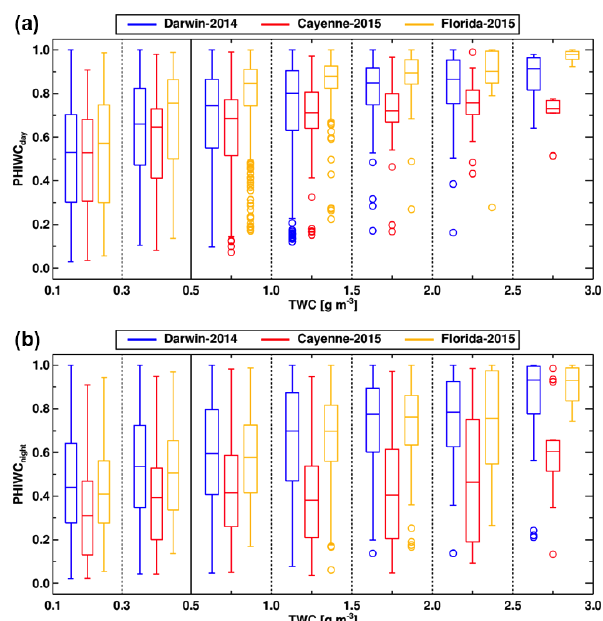
Figure 13. Box and whisker diagrams showing the relationship between PHIWC day (top, N = 4598 satellite–aircraft matches), PHIWC night (bottom, N = 5371) and TWC. The rectangles show the intraquartile PHIWC range for each TWC bin. The horizontal line within the rectangles shows the median PHIWC. The whiskers show the range of the 1.5 and 98.5% of the distribution and circles are